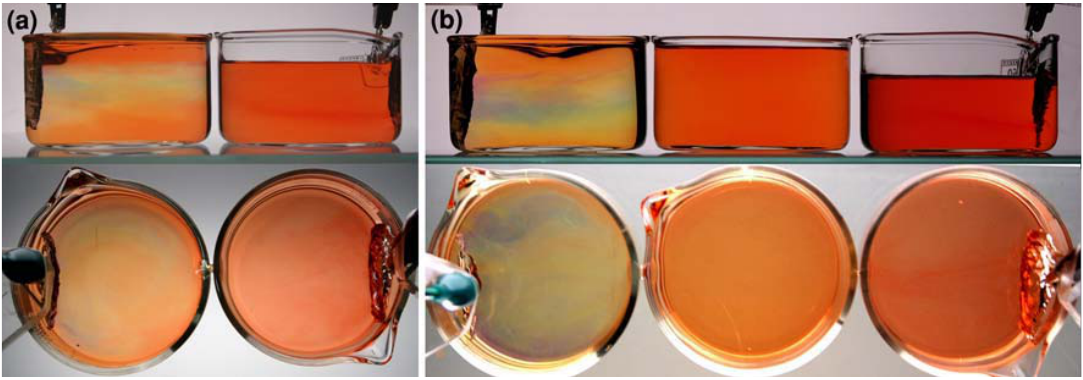
Figure 15. Visualization of the pH value during bridge operation from red (pH 4) to violet (pH 10) for (a) a two beaker and (b) a three beaker arrangement. With orange pH 5, yellow pH 6, green pH 7, cyan pH 8 and blue pH 9. Before bridge operation the water had a pH value of 5 (orange). The color impression also depends on the thickness of the water layer (from [92]).